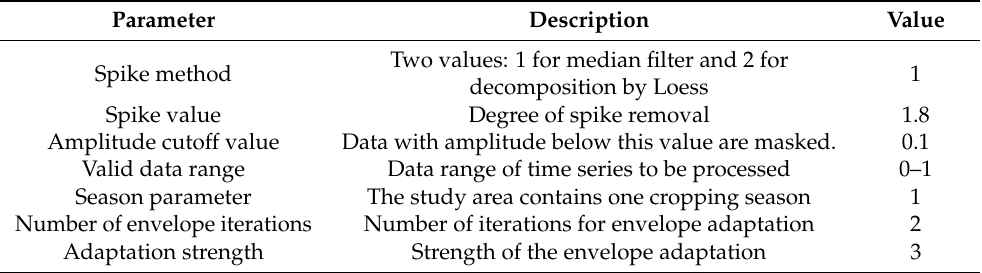
Table 1. Input setting for NDVI time series processing in TIMESAT used in this study, as recom- mended by [52].